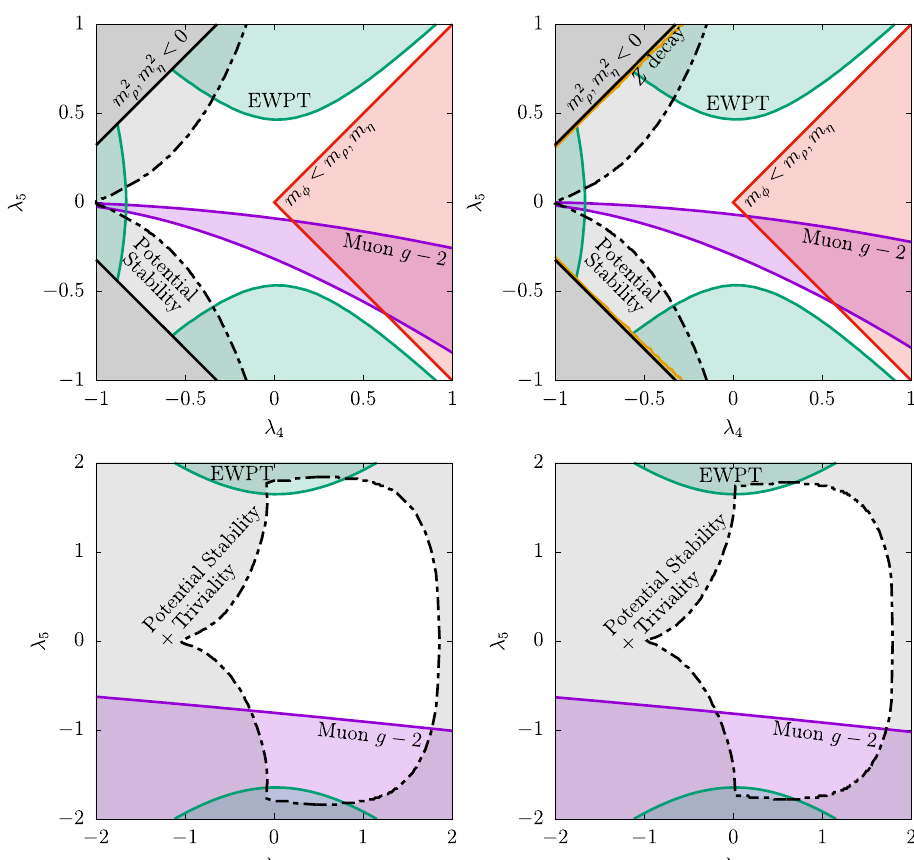
Figure 5 . Numerical analysis in ( (cid:21) 4 , (cid:21) 5 ) plane, where the charged scalar mass and Yukawa couplings ( m (cid:30) , y (cid:22)(cid:28) , y (cid:28)(cid:22) ) are (cid:12)xed as (200 GeV, 0 : 20, 0 : 20) on top left panel, (200 GeV, 0 : 04, 1 : 00) on top right panel, (700 GeV, 0 : 70, 0 : 70) on bottom left panel, and (700 GeV, 0 : 41, 1 : 20) on bottom right panel,